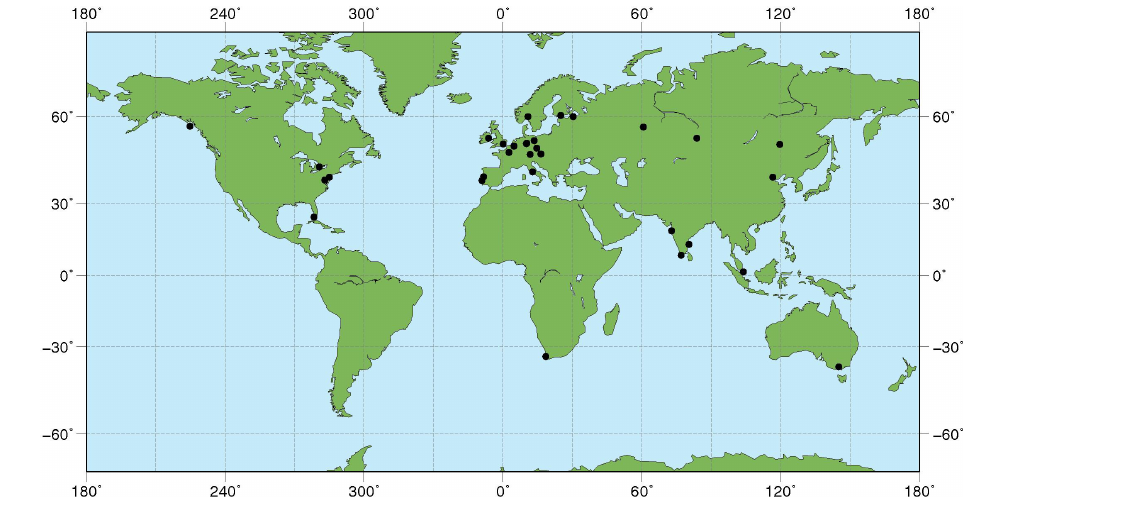
Figure 1. Distribution of magnetic and meteorological observatories in 1850 (Nevanlinna and Häkkinen, 2010). The number of observatories was 30. Today, there are some 200 observatories around the